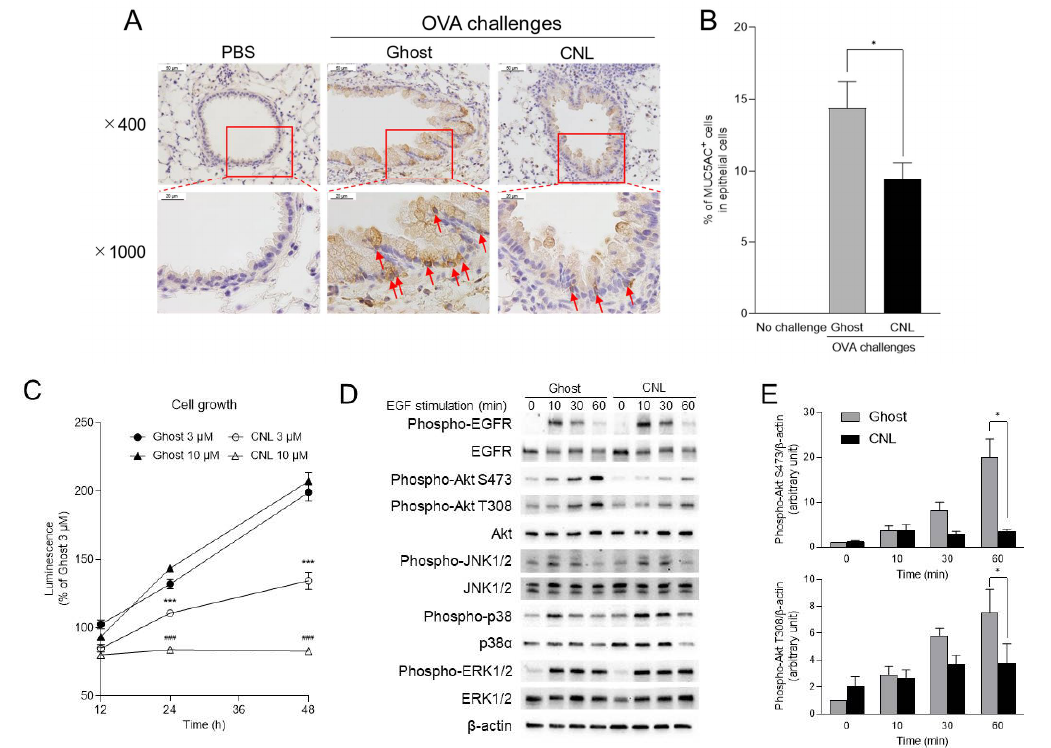
Figure 5. Effects of ceramide nanoliposomes (CNL) on goblet cell hyperplasia. ( A , B ) OVA-sensitized mice were challenged with OVA-free PBS or OVA. OVA-challenged asthmatic mice were treated with 30 μg/animal ceramide-free Ghost or CNL. Lung tissue sections were stained with MUC5AC antibody. Representative images of the immunohistochemistry on airway epithelia are shown and arrows show goblet cells ( A ). The ratios of goblet cells to total epithelial cells were determined ( B ). Data are shown as mean ± S.E. ( n = 10). * p < 0.05 compared to the Ghost group. ( C ) Human lung epithelial A549 cells (4000 cells/well) were treated with the indicated concentration of Ghost or CNL for up to 48 h. Cell viability was determined using a CellTiter-Glo luminescent cell viability assay. Data are shown as mean ± S.E. ( n = 4). Dose- and time-matched statistical analysis were performed. *** p < 0.001 compared to the Ghost 3 µ M group. ### p < 0.001 compared to the Ghost 10 µ M group. ( D ) A549 cells were treated with 10 µ M Ghost or CNL for 6 h followed by stimulation with 100 ng/mL EGF for the indicated periods. Proteins were subjected to immunoblot analysis. Results are representative of three independent experiments. ( E ) Intensity of the immunoblots were quantified and phospho-Akt/ β -actin values were calculated. The values are shown as percentages relative to Ghost 0 min group. Data are shown as mean ± S.E. ( n = 3). * p < 0.05 compared to Ghost